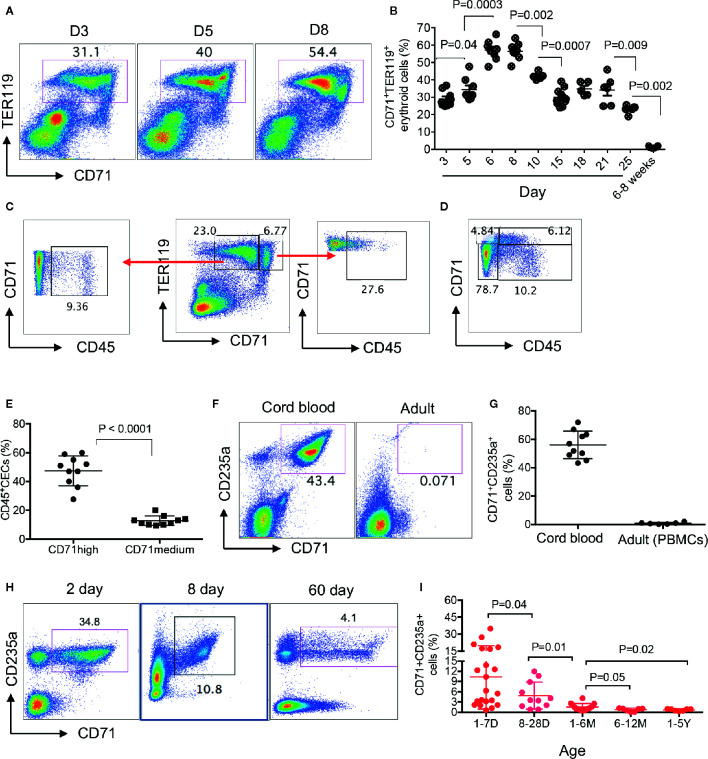
Physiological abundance of CECs in newborns. (A) Representative flow cytometry plots of frequency of CECs in the spleen of days 3, 5, and 8 mice. (B) Cumulative data showing percentages of CECs in spleens of day-3 to adult (6–8 weeks) mice. (C, D) Representative plots showing percentages of CD45+ in TER119+CD71medium and TER119+CD71high CECs. (E) Cumulative data showing percentages of CD45+ subpopulation of CECs in TER119+CD71medium and TER119+CD71high CECs in the spleen of neonatal mice. (F) Representative plots of frequency of CECs in the cord blood or the peripheral blood of human adults. (G) Cumulative data showing the percentages of CECs in the cord blood versus the peripheral blood of adult humans. (H) Representative plots of frequency of CECs in the peripheral blood of human newborns (days 2 and 8 and 2 months). (I) Cumulative data showing the frequency of CECs in the peripheral blood of human infants/children from day 1 to 5 years of age. Each point represents data from an individual mouse or human subject (adult, cord blood, or neonatal blood). Bar, mean ± one standard error.